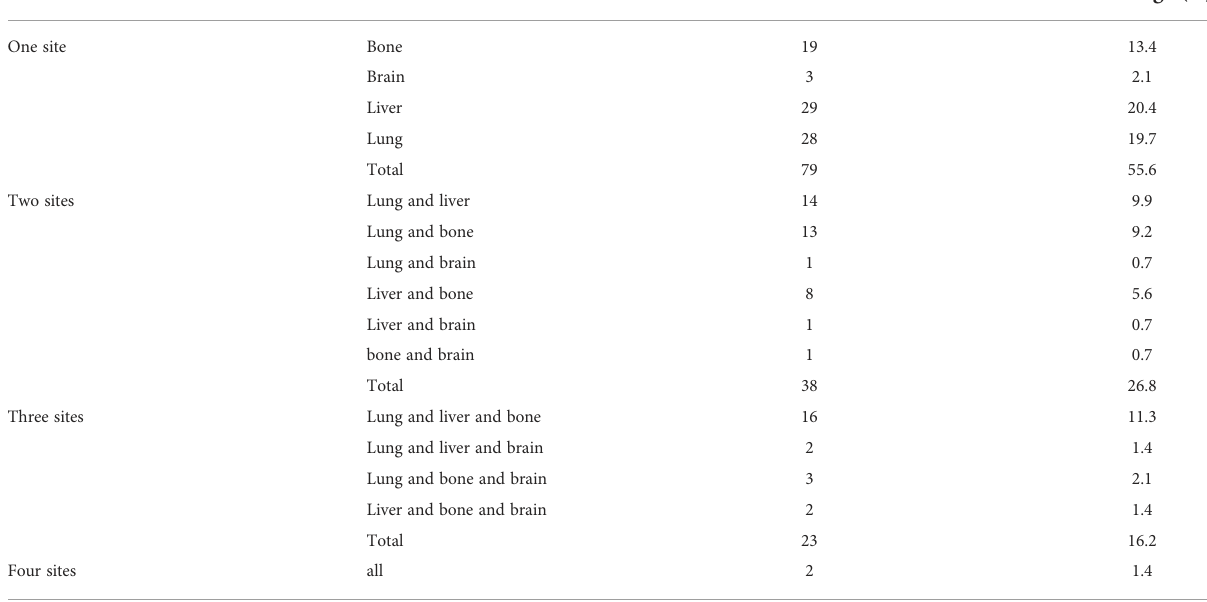
TABLE 2 Frequencies of different metastasis sites and combination metastasis